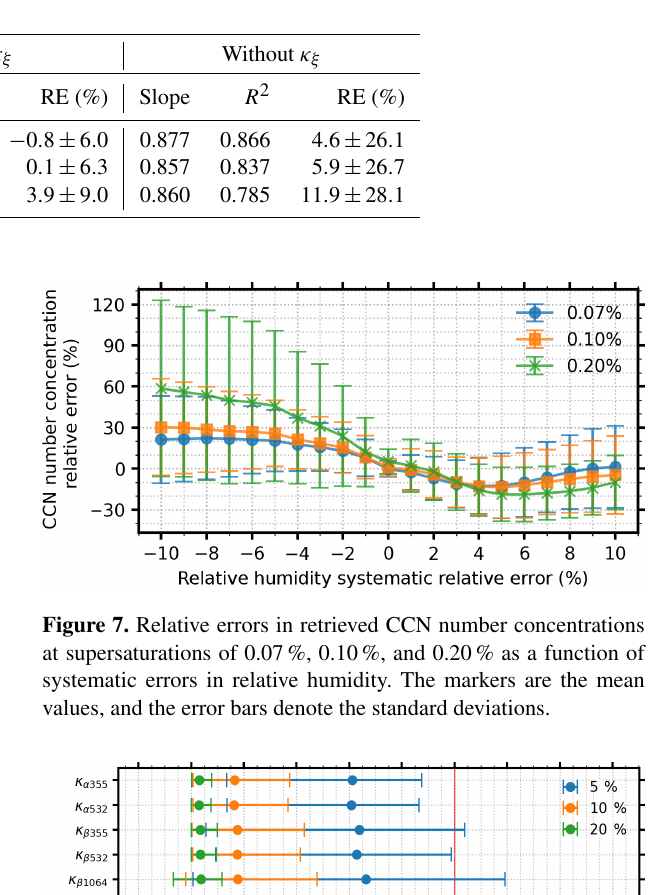
Table 5. Slopes of linear regressions, determination coefficients ( R 2 ), and relative errors (RE) between theoretical calculated CCN number concentrations and CCN number concentrations retrieved with and without κ ξ as input parameter. The relative errors are given in the form of mean value ± 1 standard deviation.